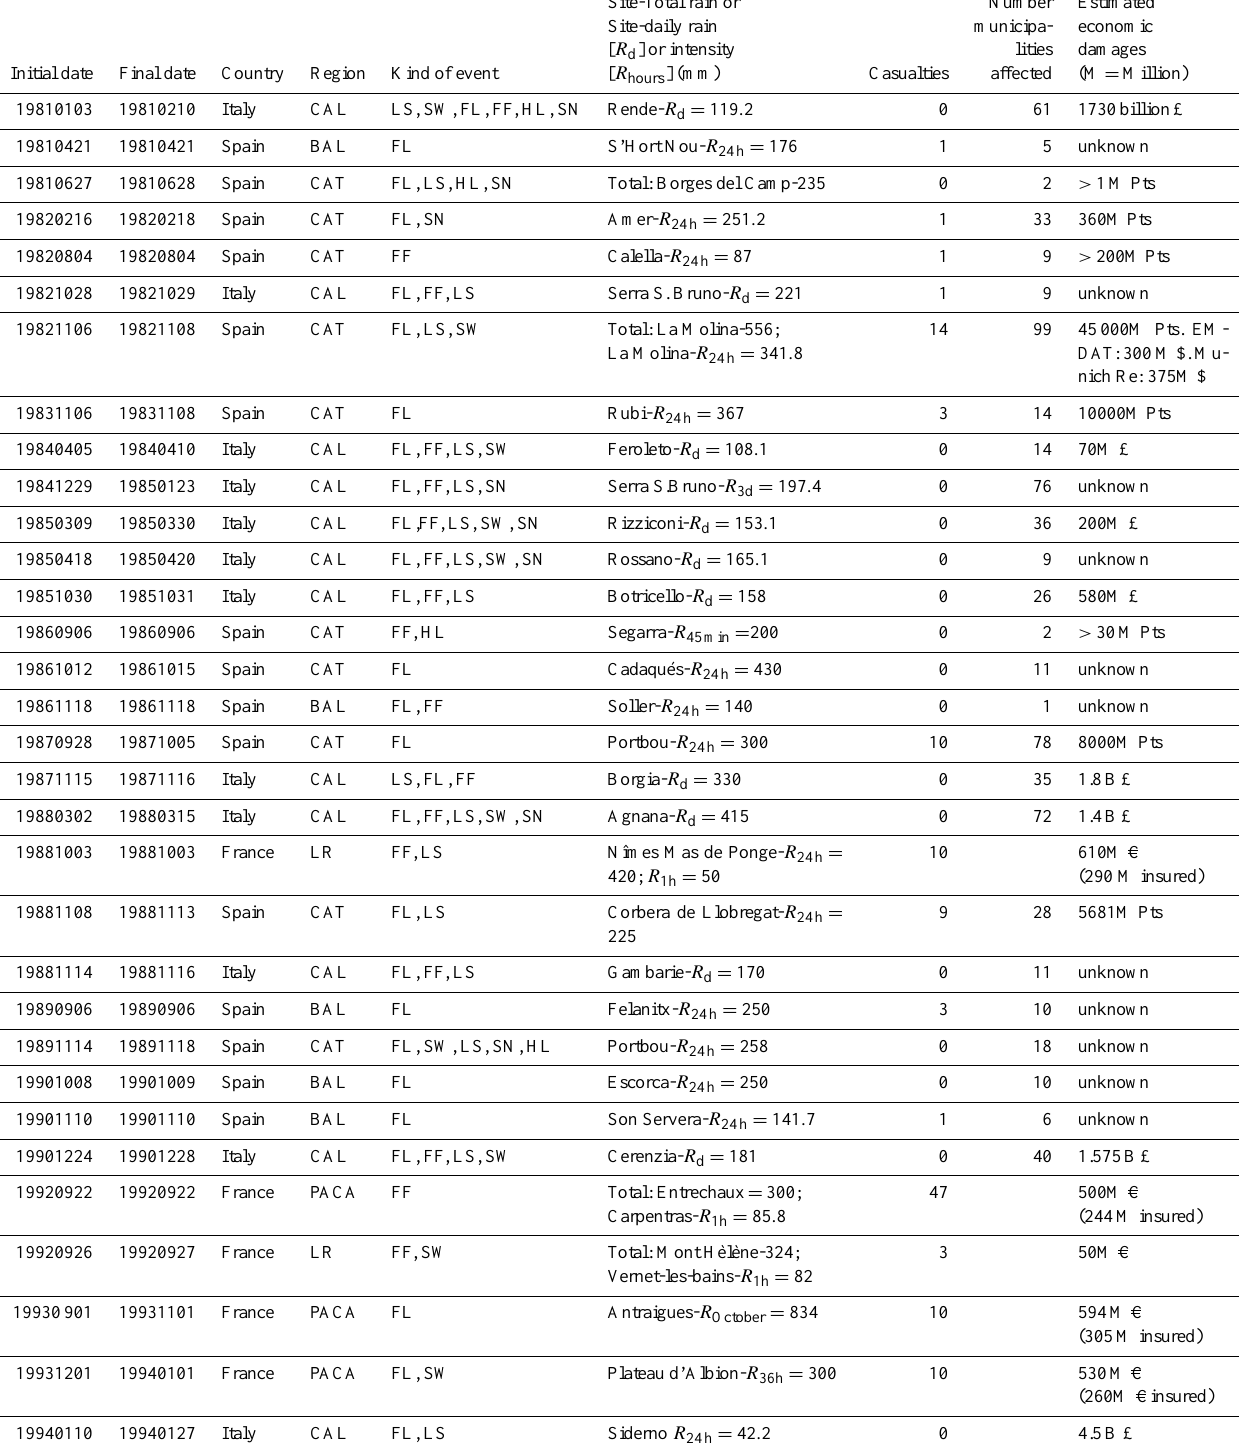
Table A1. Catastrophic floods recorded between 1981 and 2010 in the selected regions of the study (Keywords: FL: flood, FF: flash flood, HL: hail, LS: landslide, SN: snow, SW: strong wind, TO: tornado). Regions: CAL: Calabria (Italy), BAL: Balearic Islands (Spain), CAT: Catalonia (Spain), PACA: Provence-Alpes-Cˆote d’Azur (France), LR: Languedoc-Roussillon (France), MP: Midi-Pyr´en´ees